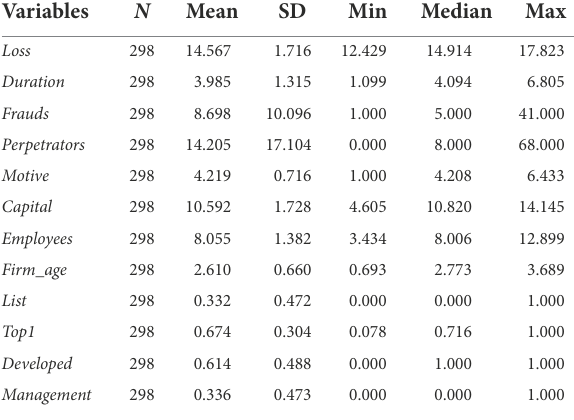
TABLE 9 Descriptive statistics of the variables in predictive validity